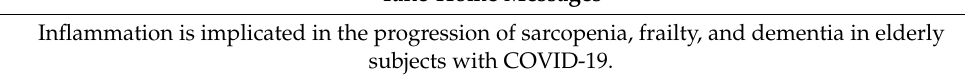
Table 1. Take-home messages about COVID-19 infection and frailty. Take-Home